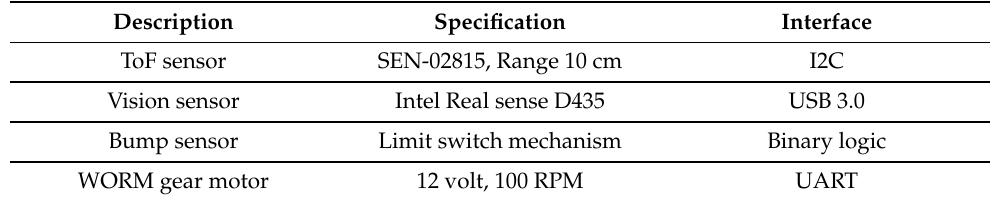
Table 1. Hardware and sensor specification.